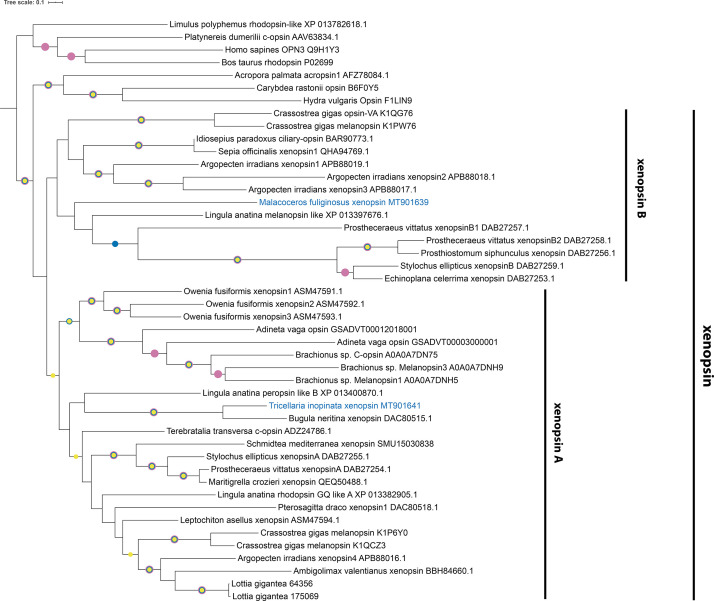
Xenopsin tree rooted with few c-opsins and cnidops.Labeled nodes have support values of approximate Bayes test ≥0.98 (yellow dot), SH-like approximate likelihood ratio test ≥90 (blue dot), and ultrafast bootstrap ≥90 (purple dot). The sequences investigated in this study are highlighted in blue.